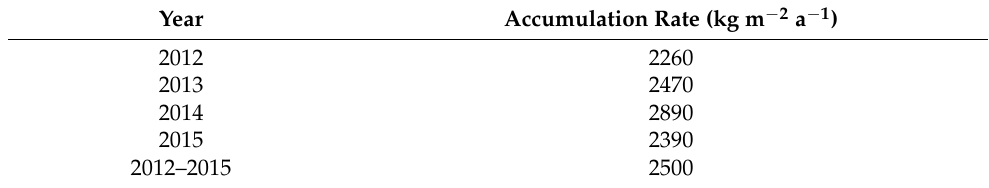
Table 1. Annual accumulation rates calculated for the OH-12 drill site for the period 2012–2015.